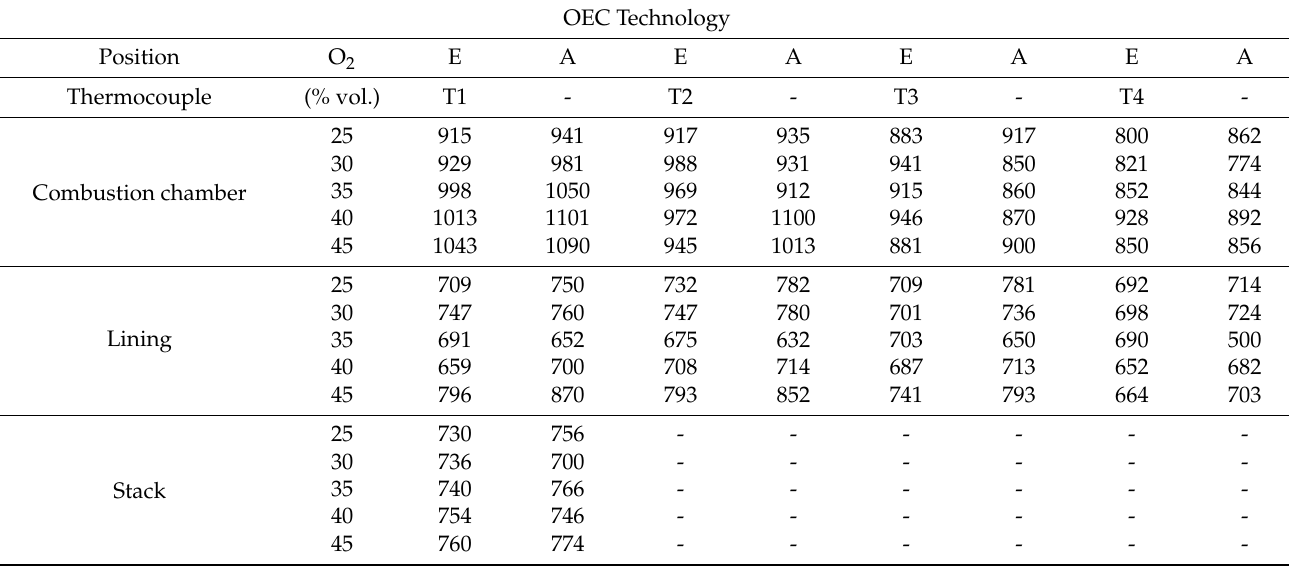
Table A1. Comparison of results from CFD modeling with experimental results using OEC technology.